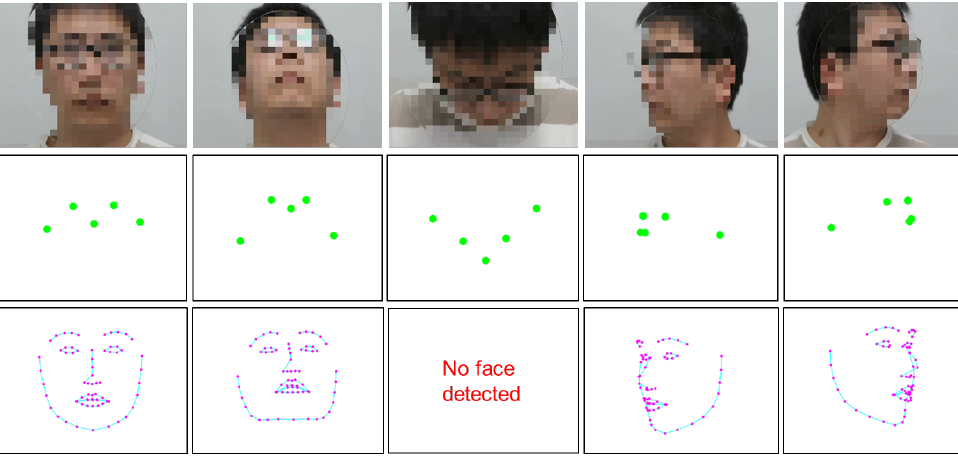
Figure 11. Outputting feature positions from bone sensing and face recognition,